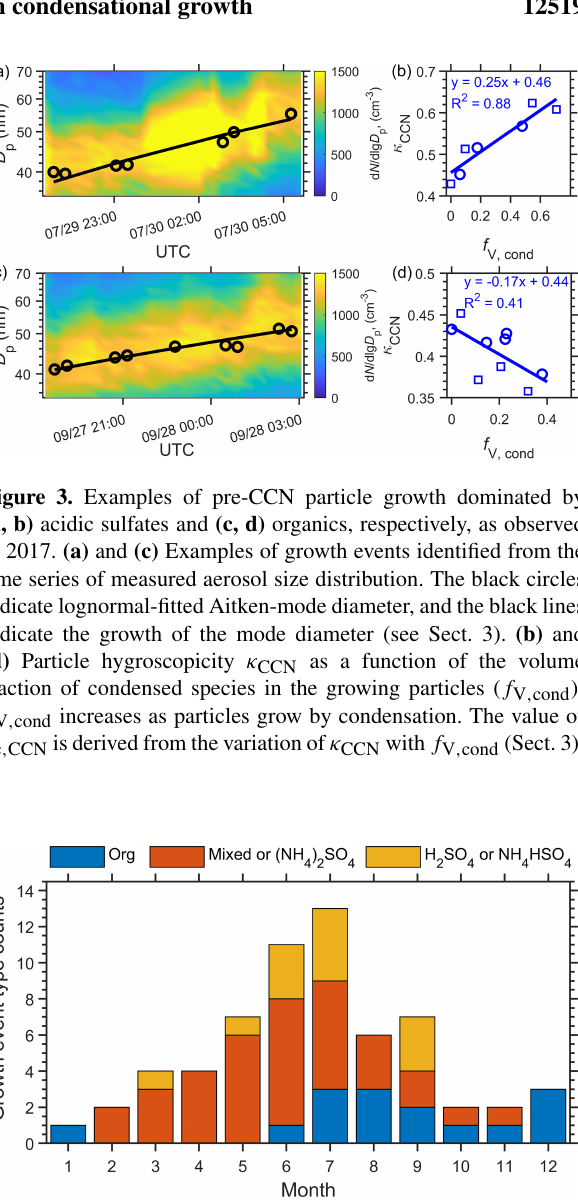
Figure 4. Monthly distribution of observed condensational growth events and the category of dominant condensing species during the ACE-ENA